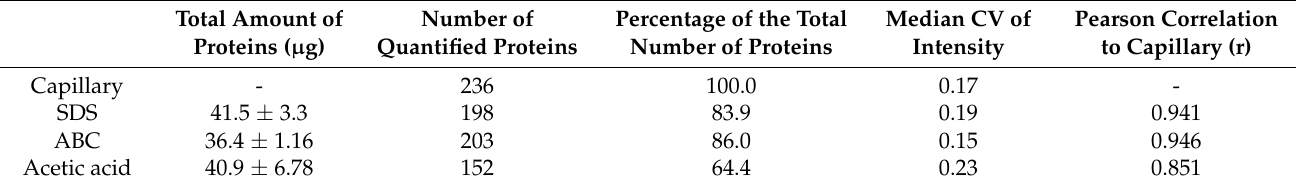
Table 1. Comparison of tear protein extraction methods from